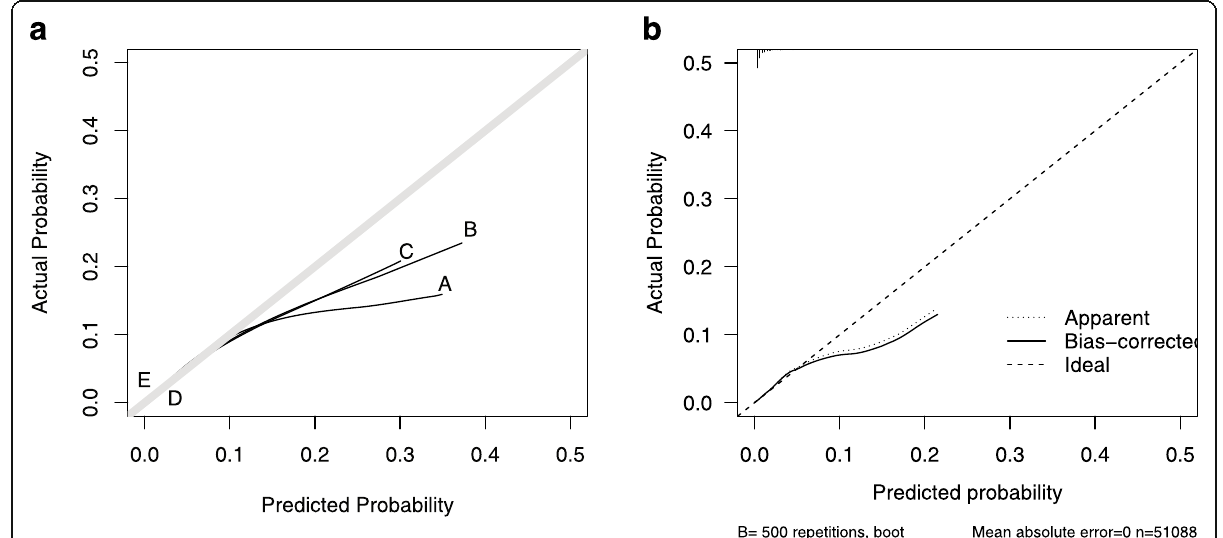
Fig. 2 a Calibration plot of various TB screening models A to E. b Calibration plot of validated data of social pathology model C (Bootstrap